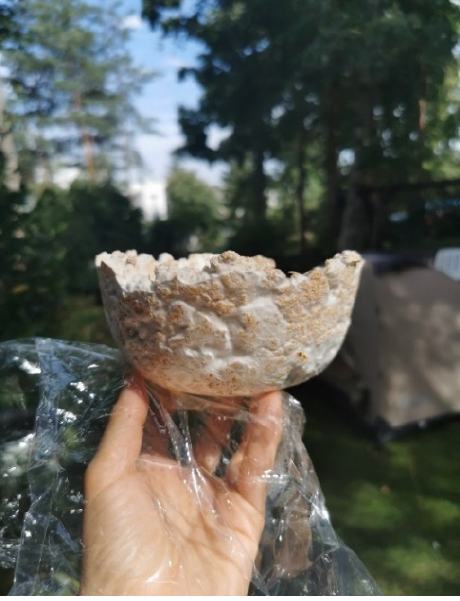
Figure 12. Mycelium-based semi-finished object (design and photo: A. Bonenberg). Similarly, a container bowl was created, where an upper part of the object was fixed to the rough-timber torus-shaped base (Figures 12 and 13). Again, the look of the object is “organic”. At the same time, the heavier wooden base gives the bowl its functional stability.